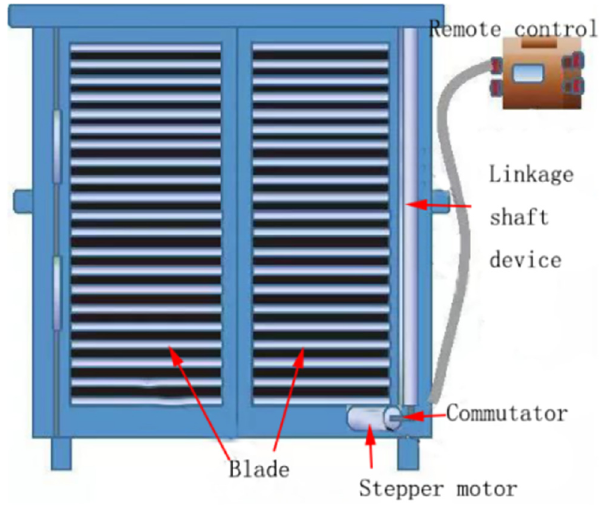
Fig. 2. Rotating vane type remote control air